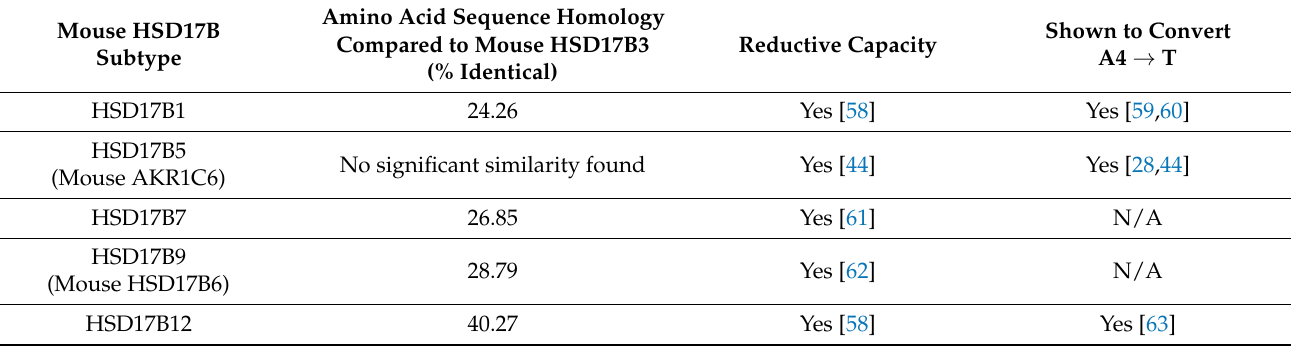
Table 2. Amino acid sequence homology of mouse HSD17B3 with other mouse HSD17B